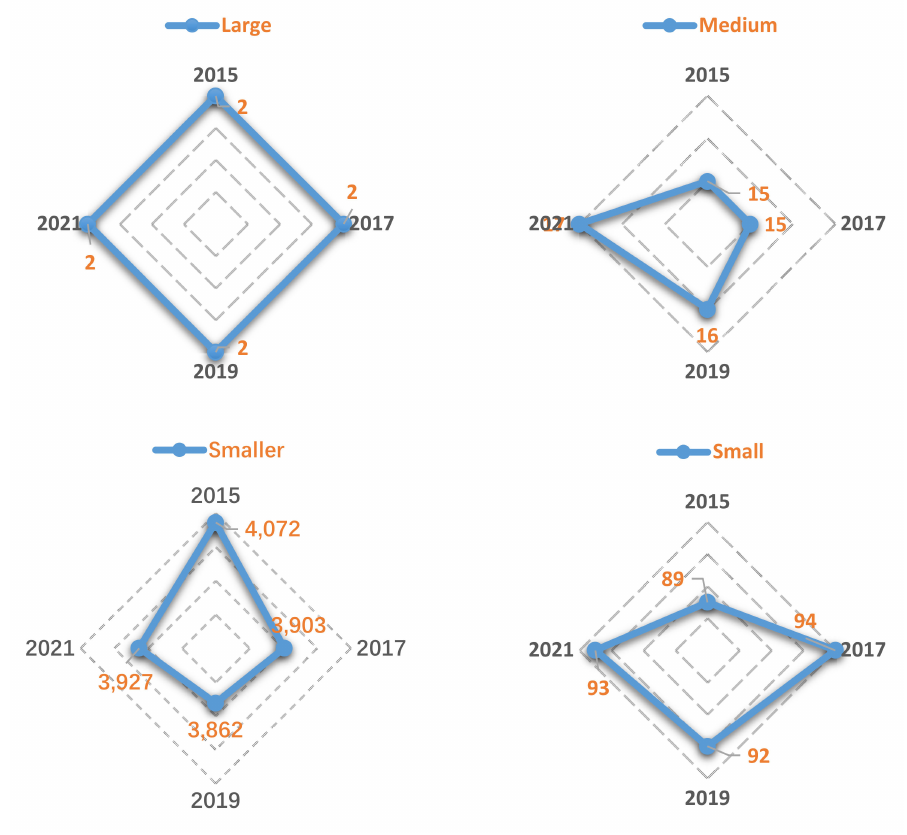
Figure 14. Changes in the number of lakes at different